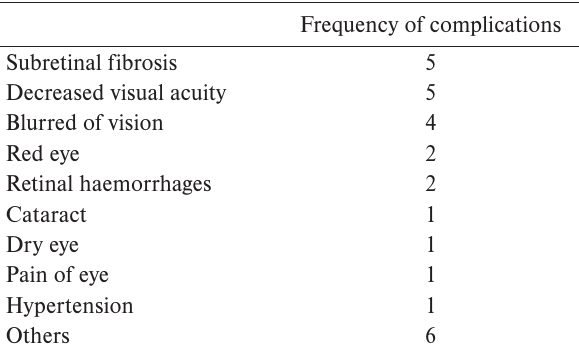
Table 1. Complications of the